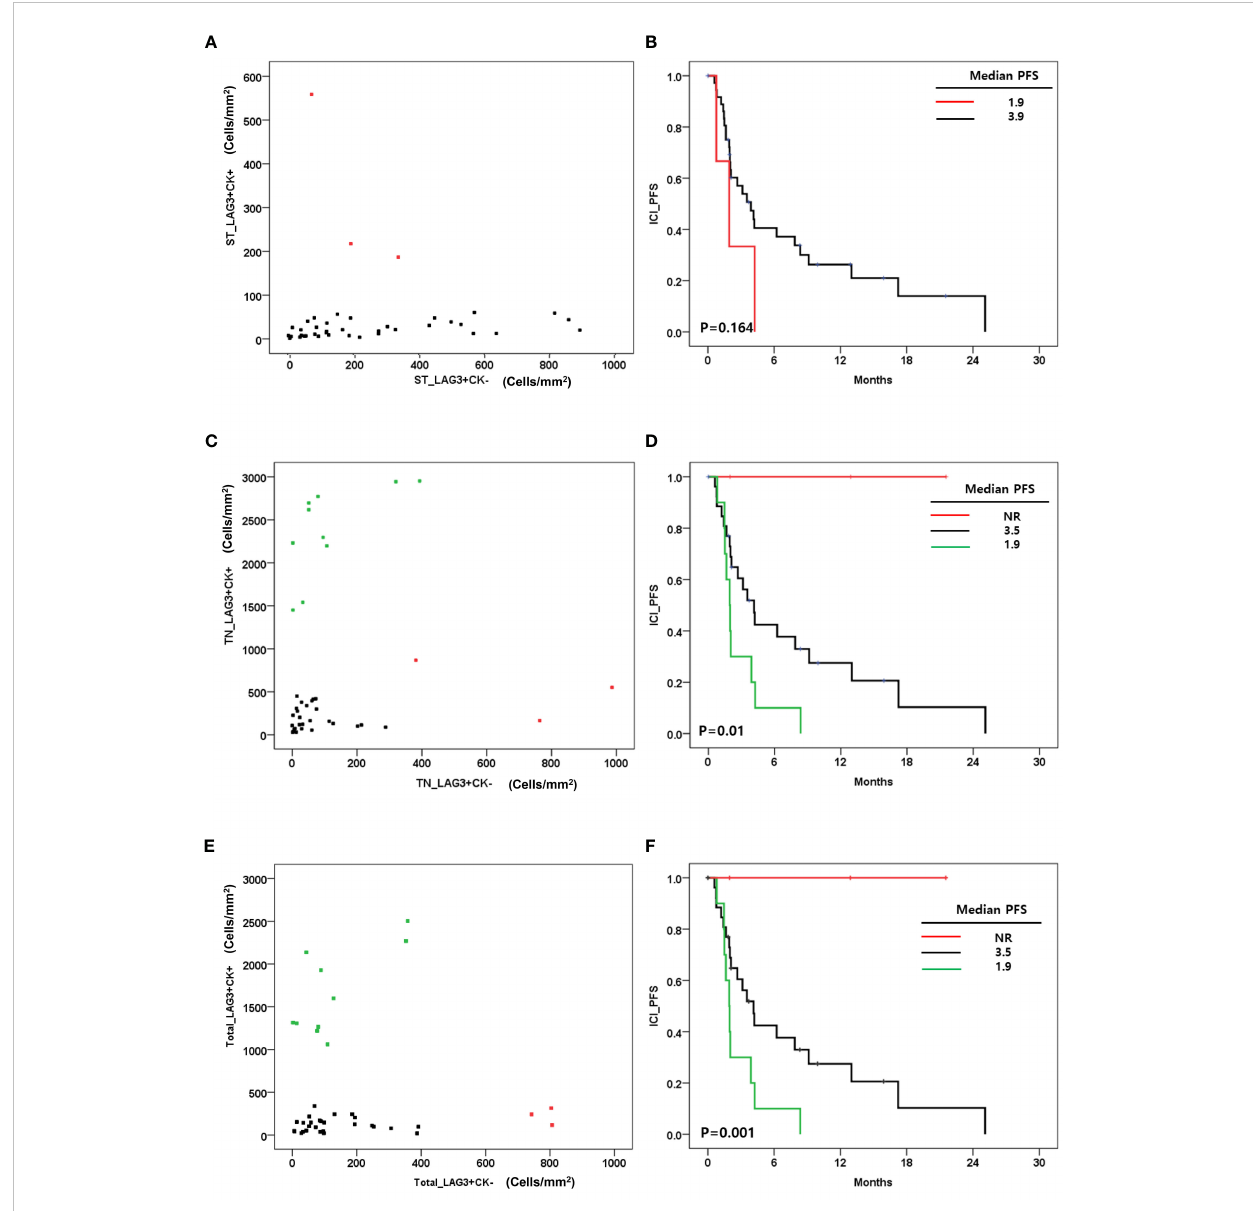
FIGURE 4 (A) Correlation between the level of LAG-3+CK+ cells and LAG-3+CK- cells in stroma (cells/mm2); (B) Immune checkpoint inhibitor progression free survival(ICI_PFS) according to level of LAG-3+CK+ cells in stroma(cells/mm2); (C) Correlation between the level of LAG-3+CK+ cells and